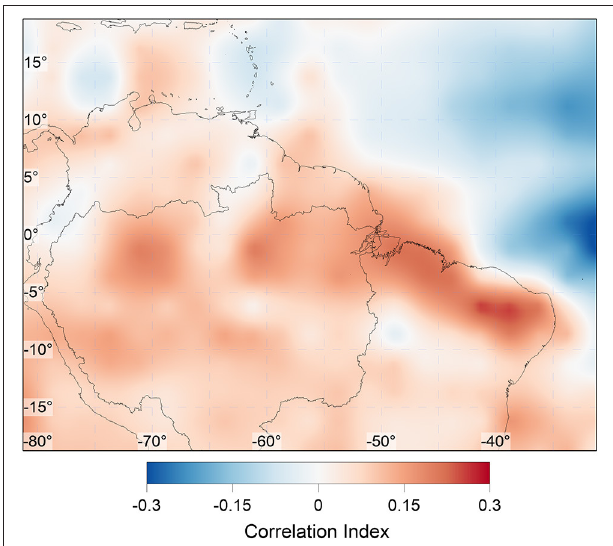
FIGURE 12 | Cross-correlation between EOF4 principal component and GPCP rainfall anomalies over land and ocean, from 1979 to